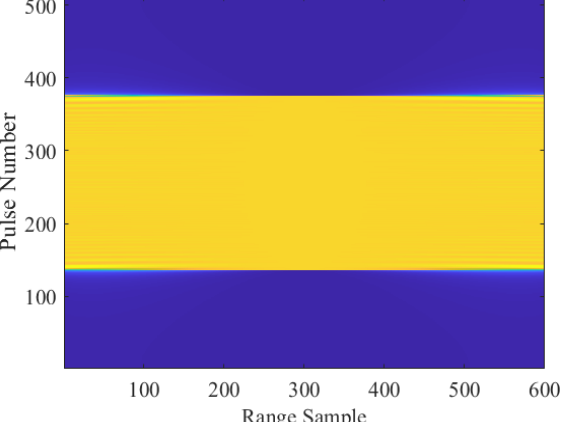
Figure 11. SAR echo signal simulation result of point target experiment.